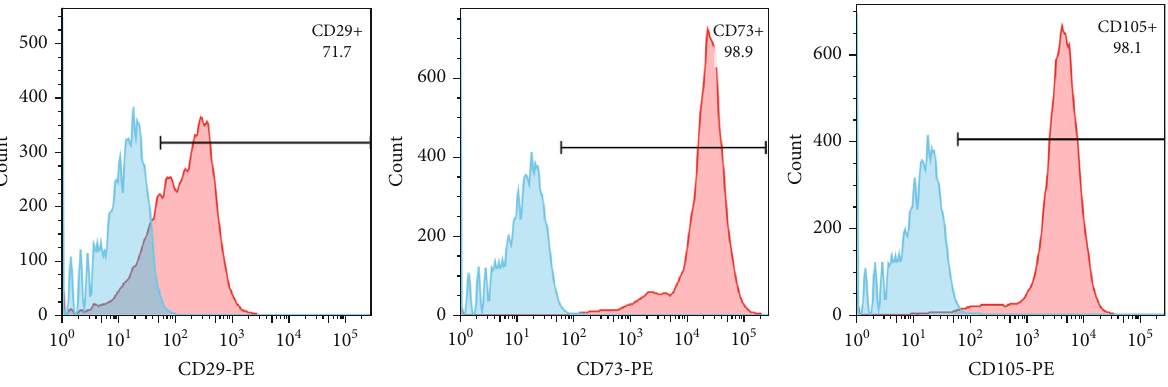
Figure 4: The third passage cells had high expression of CD29 (71.7%), CD73 (98.9%), and CD105